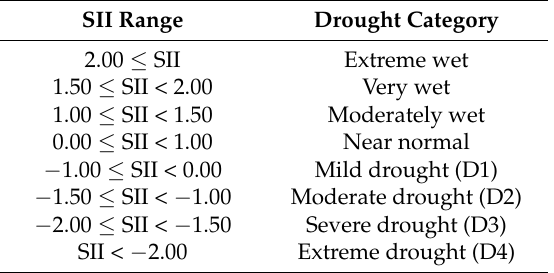
Table 1. Classification of drought severity by the range of standardized inflow index (SII).